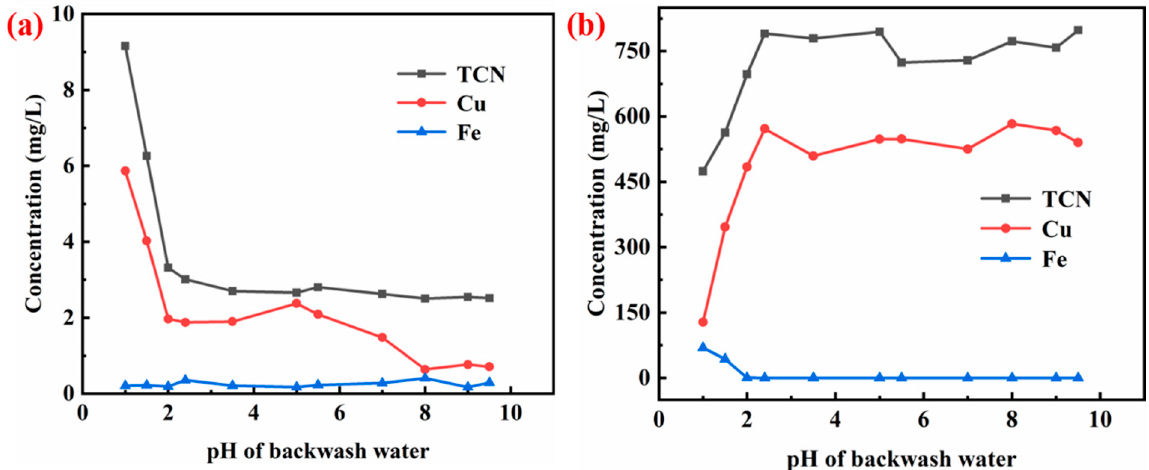
Figure 4. Effect of the pH value of the backwash water on the filter press backwash process: ( a ) leaching toxicity of backwashed cyanide tailings; ( b ) element content of elution water.